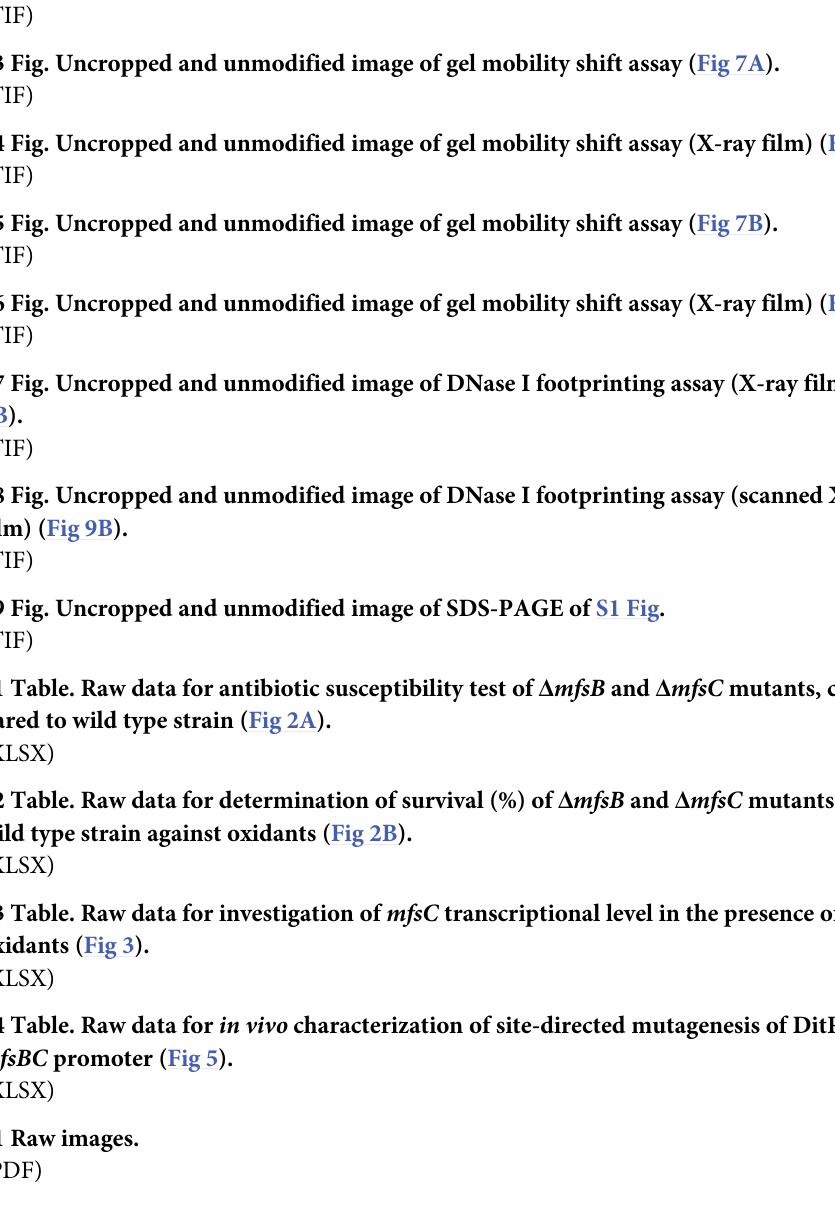
S1 Fig. Purity of purified DitR protein. The coomassie blue staining of DitR proteins (2, 5 and 10 μ g) after purification and separation by 12.5% SDS-PAGE. M represents protein molec- ular weight markers. (TIF) S2 Fig. Uncropped and unmodified image of end-point RT-PCR (Fig 4B). (TIF) S3 Fig. Uncropped and unmodified image of gel mobility shift assay (Fig 7A). (TIF) S4 Fig. Uncropped and unmodified image of gel mobility shift assay (X-ray film) (Fig 7A). (TIF) S5 Fig. Uncropped and unmodified image of gel mobility shift assay (Fig 7B). (TIF) S6 Fig. Uncropped and unmodified image of gel mobility shift assay (X-ray film) (Fig 7B). (TIF) S7 Fig. Uncropped and unmodified image of DNase I footprinting assay (X-ray film) (Fig 9B). (TIF) S8 Fig. Uncropped and unmodified image of DNase I footprinting assay (scanned X-ray film) (Fig 9B). (TIF) S9 Fig. Uncropped and unmodified image of SDS-PAGE of S1 Fig. (TIF) S1 Table. Raw data for antibiotic susceptibility test of Δ mfsB and Δ mfsC mutants, com- pared to wild type strain (Fig 2A). S2 Table. Raw data for determination of survival (%) of Δ mfsB and Δ mfsC mutants, and wild type strain against oxidants (Fig 2B). S3 Table. Raw data for investigation of mfsC transcriptional level in the presence of several oxidants (Fig 3). S4 Table. Raw data for in vivo characterization of site-directed mutagenesis of DitR on mfsBC promoter (Fig 5).